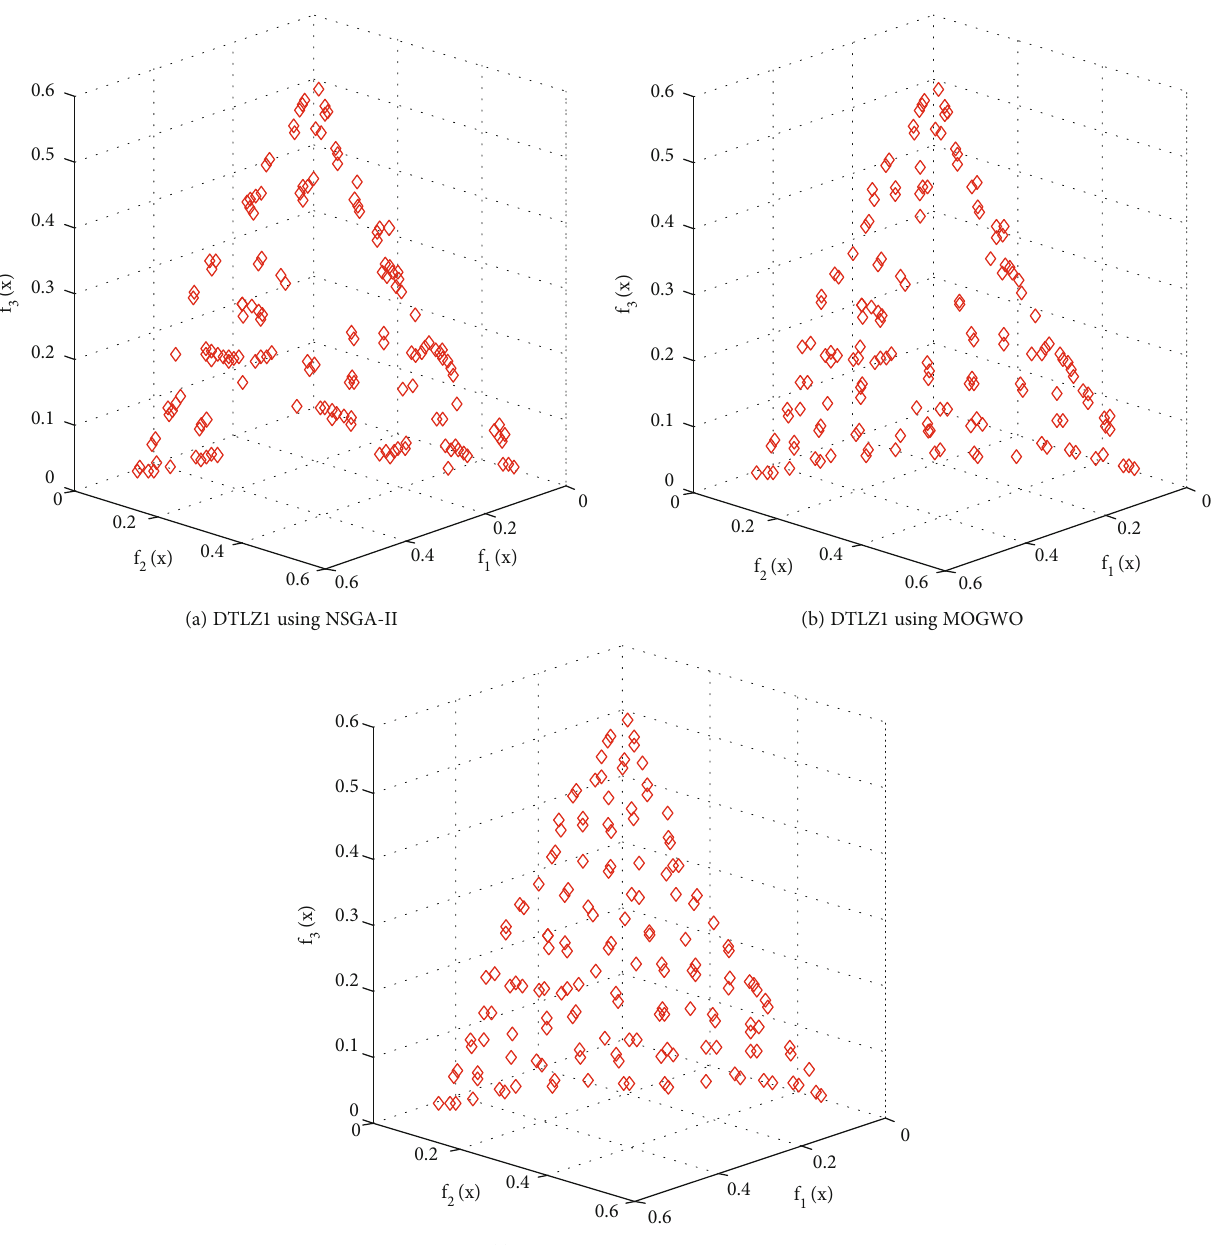
Figure 6: Paretofront obtained by solving DTLZ1 with 3 algorithms: (a) NSGA-II, (b) MOGWO, and (c)